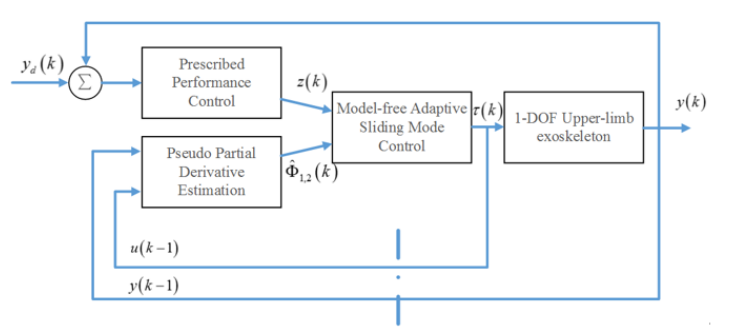
Figure 2. The original MFAC-SMC-PPC control